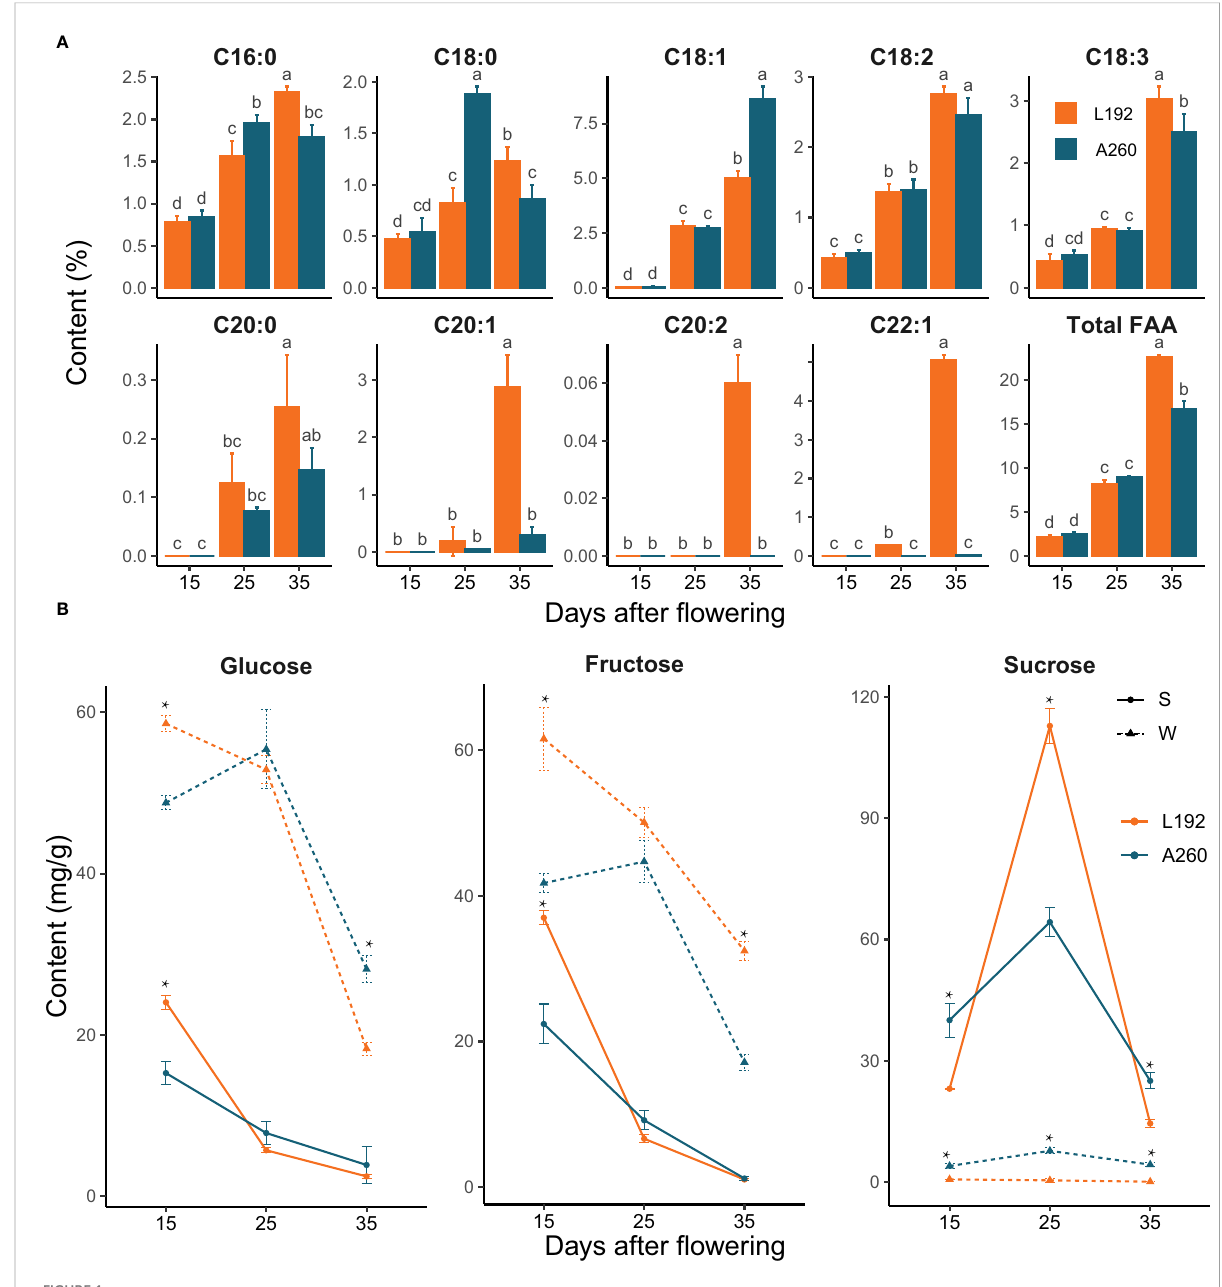
FIGURE 1 Fatty acid or sugar variability at 15, 25 and 35 DAF during silique development. (A) Changes in the content of different types of fatty acids in the seeds at 15, 25 and 35 DAF. The bars represent the means of three biological replicates, and error bars are standard deviations. Different letters marked on bars indicate signi fi cant differences according to t test analyses (p < 0.05) among groups. (B) The sugar content of the seed or silique wall. Signi fi cant differences between mean values were calculated at each time point using t test analyses and are represented by asterisks at the p < 0.05